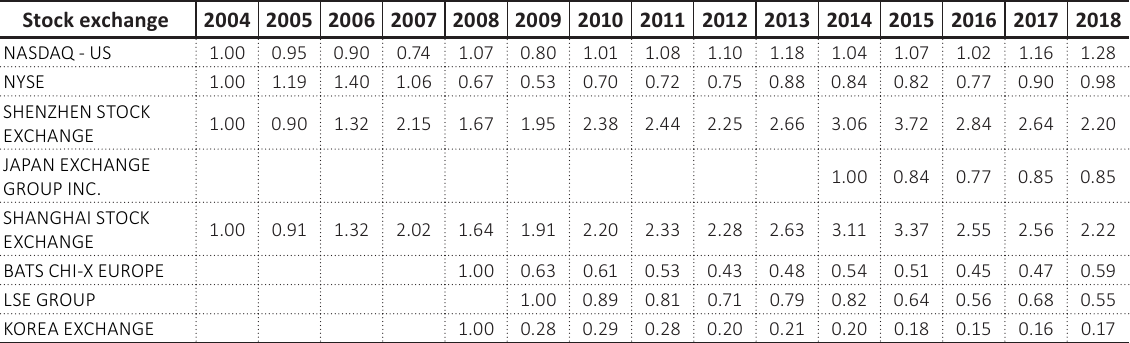
Table A2. Daily turnover-per-trade with 2004 as the base year (normalized to 1)* Stock